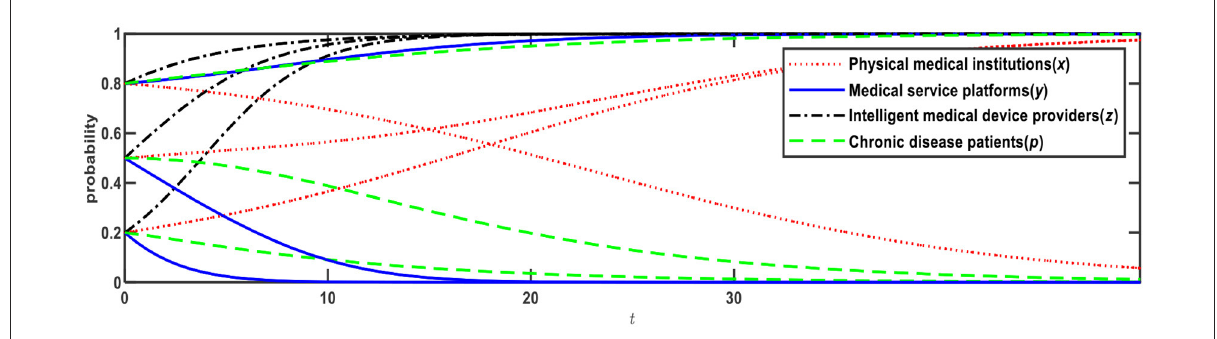
FIGURE4 Evolution of E10 (1,0,1,0) and E12